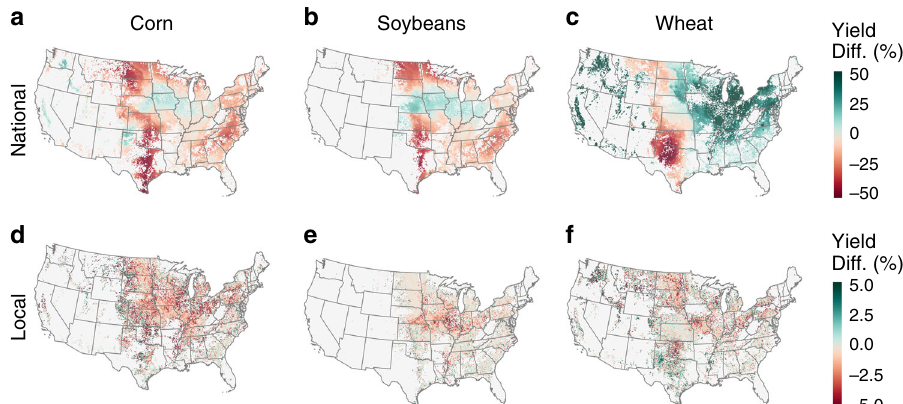
Fig. 3 Yield differentials of new croplands compared to existing croplands. Yield differential values represent the yields of new croplands relative to the yields of existing croplands nationwide ( a – c ) or within immediate 10 km x 10 km neighborhoods ( d – f ). Yields of new croplands planted to corn and soybeans were typically lower than the national average ( a , b ) and the nearby local average ( d , e ) of existing croplands for each crop. Yields of new croplands planted to wheat were generally higher than the corresponding national average ( c ) but lower than nearby existing croplands ( f